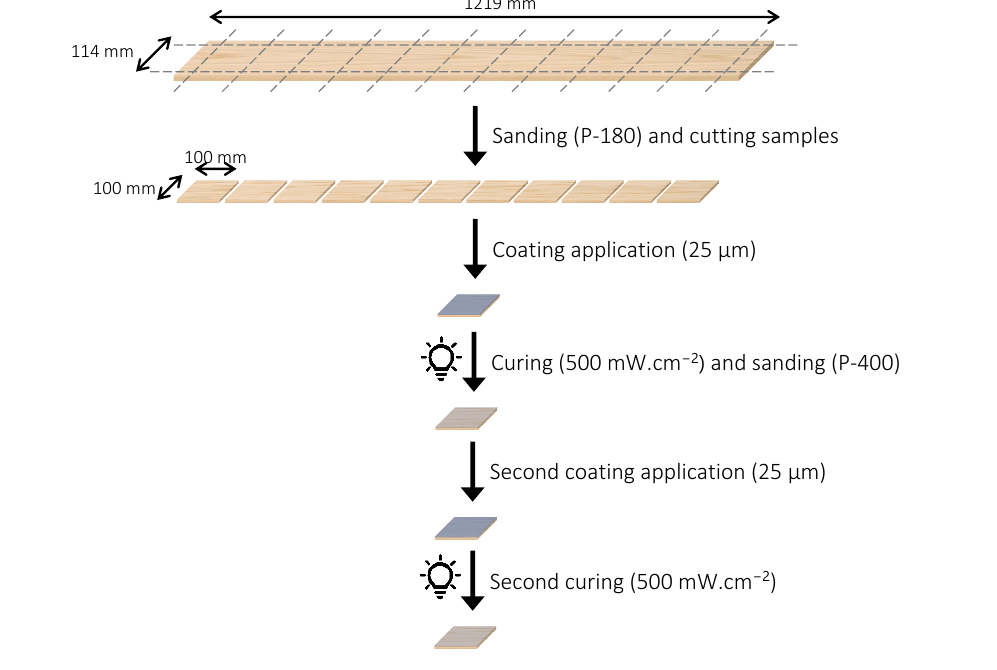
Figure 1. Wood sample preparation for the cone calorimeter test.